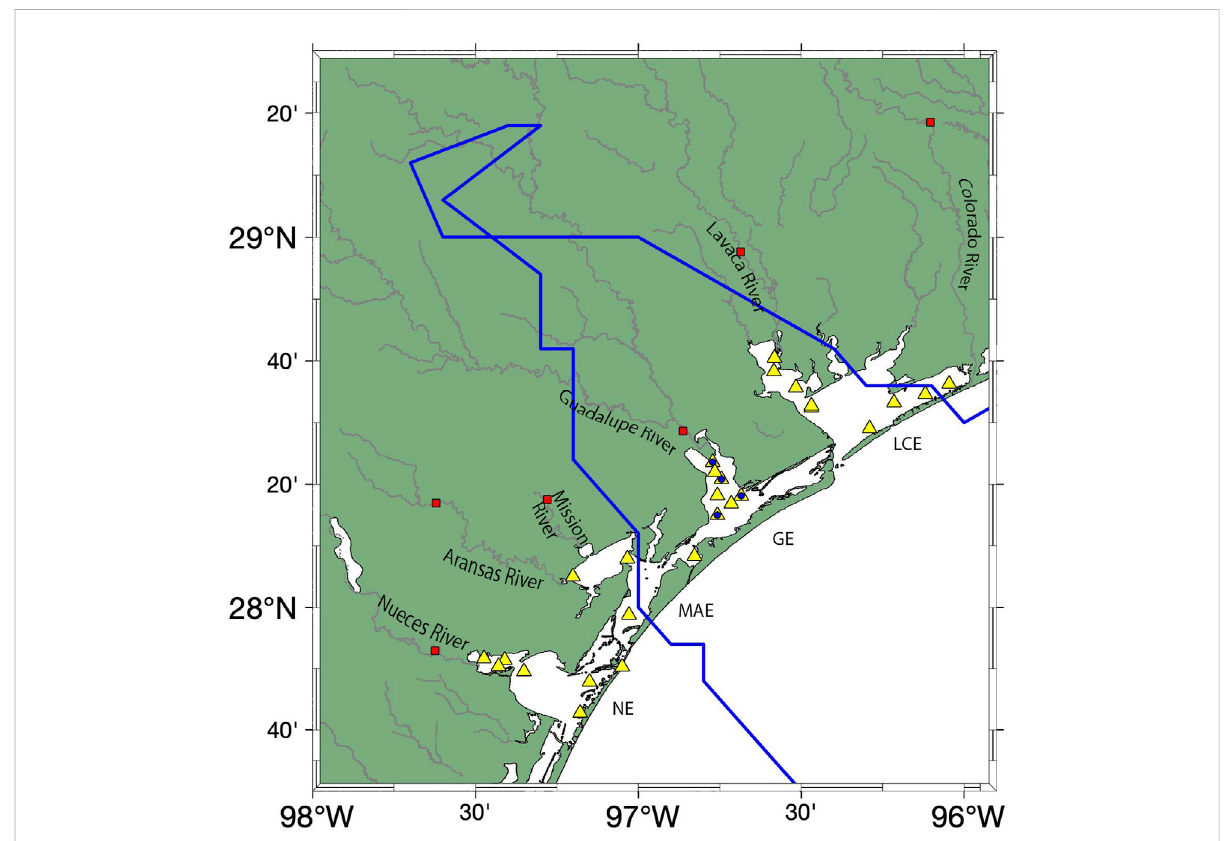
FIGURE 1 Estuarine sampling stations (yellow triangles). It is to be noted that the blue circles in the Guadalupe Estuary are the seasonal sampling stations. USGS stream fl ow gages are shown in red squares. The blue line presents the track of Hurricane Harvey in August